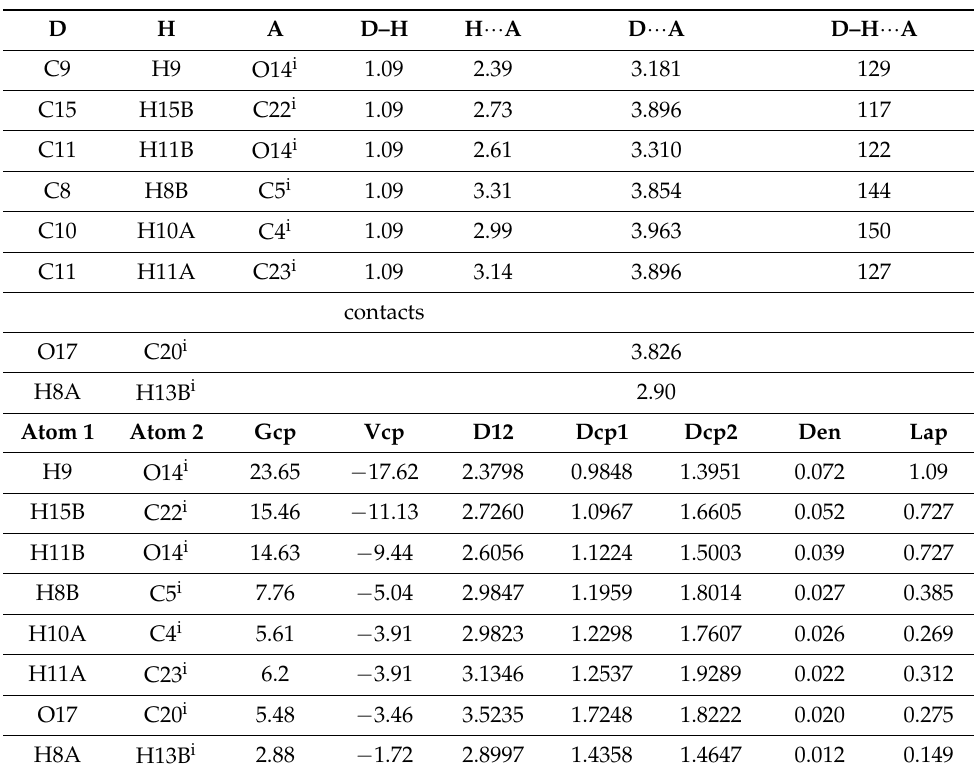
Table 4. The details of the interactions for the pair of the highest interaction energy in 1 ( i: − 1+x, y, z: 8 contacts with critical points). Upper part: geometrical details; lower: topological; D12: distance between two atoms; Gcp: kinetic energy density (kJ/mol/Bohr3); Vcp: potential energy density (kJ/mol/Bohr 3 ); Dcp1, Dcp2: distance from the first and the second atom to the critical point,